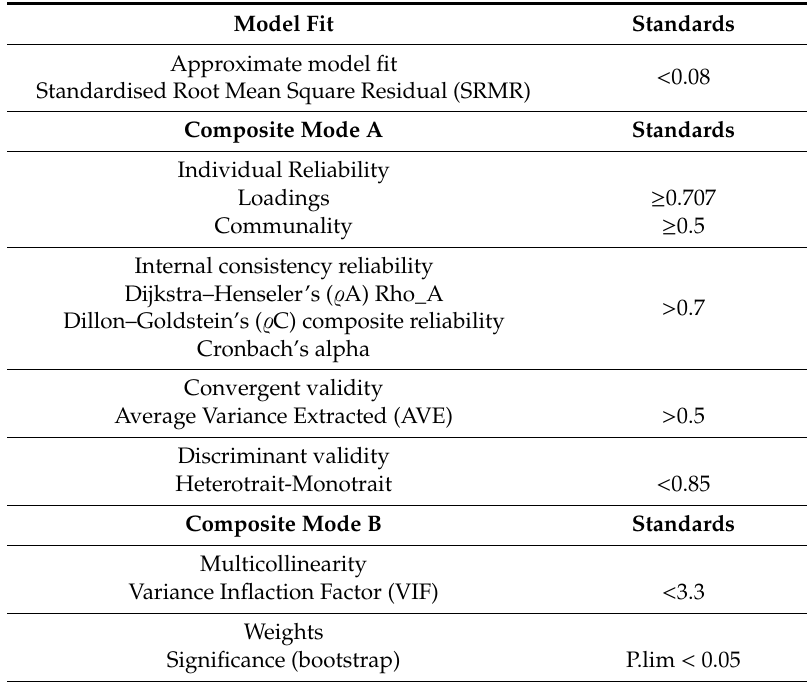
Table 1. Model minimum requirement